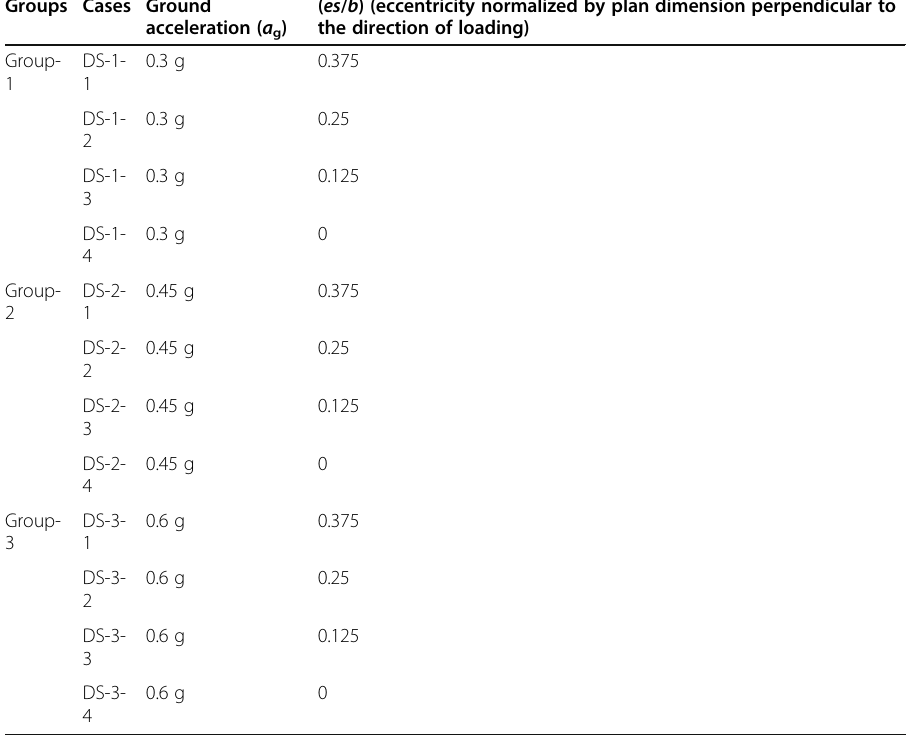
Table 3 Varied parameters of studied cases ( es / b ) (eccentricity normalized by plan dimension perpendicular to Groups Cases Ground the direction of loading) acceleration ( a g ) Group-